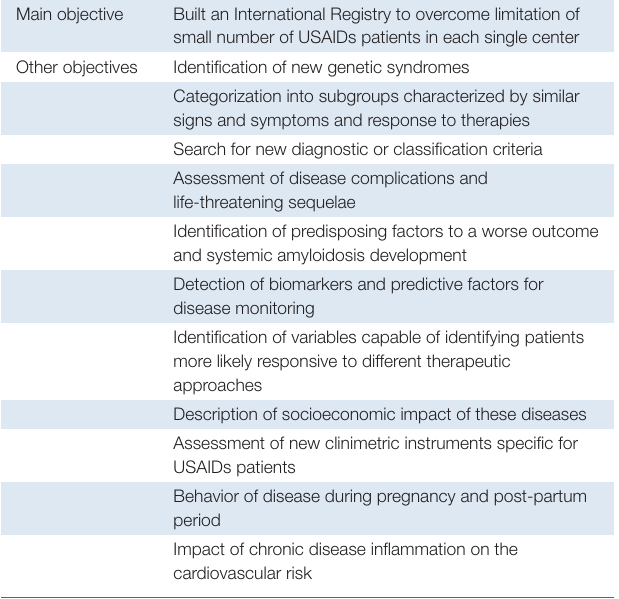
TABLE 1 | Objectives of the USAIDs